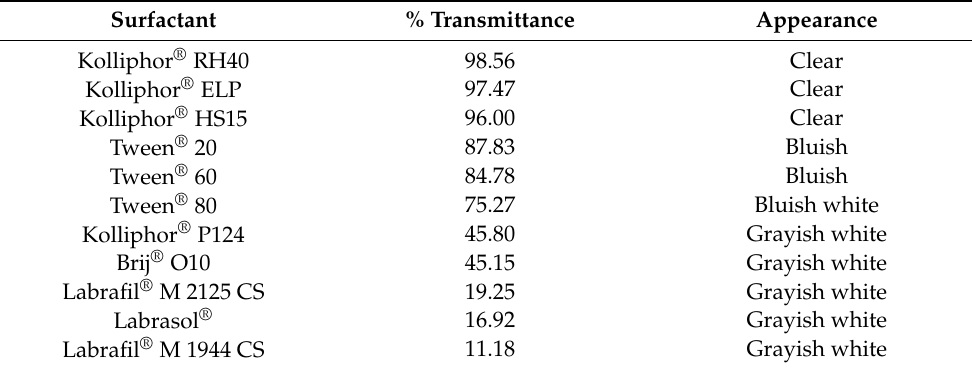
Table 1. Results of surfactant screening for Imwitor ®